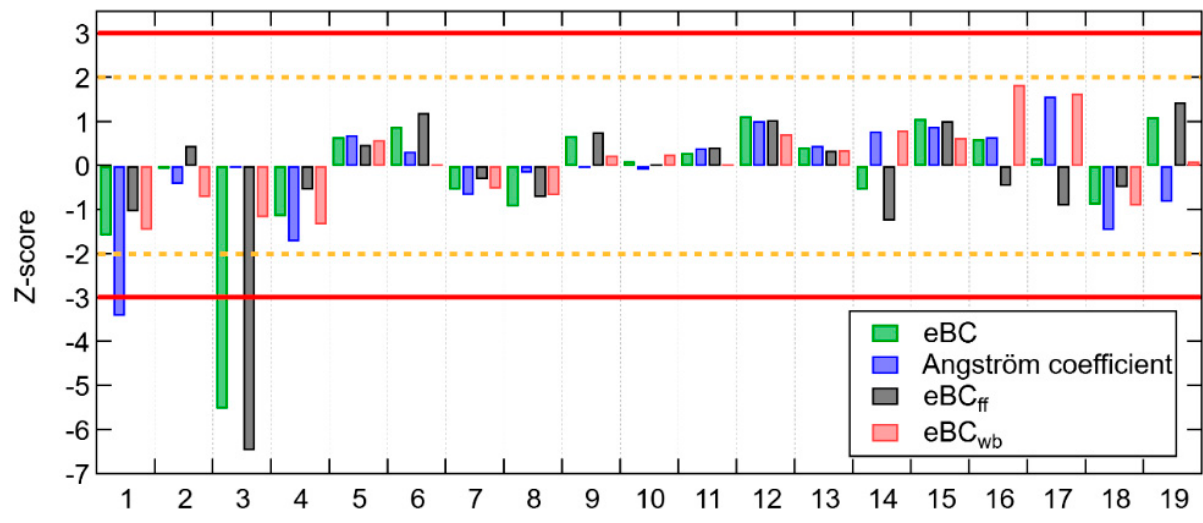
Figure 3. Z-scores obtained for BC, eBC ff , eBC wb concentrations and Angström exponent for 19 AE33 instruments (ordered according to increasing serial number).